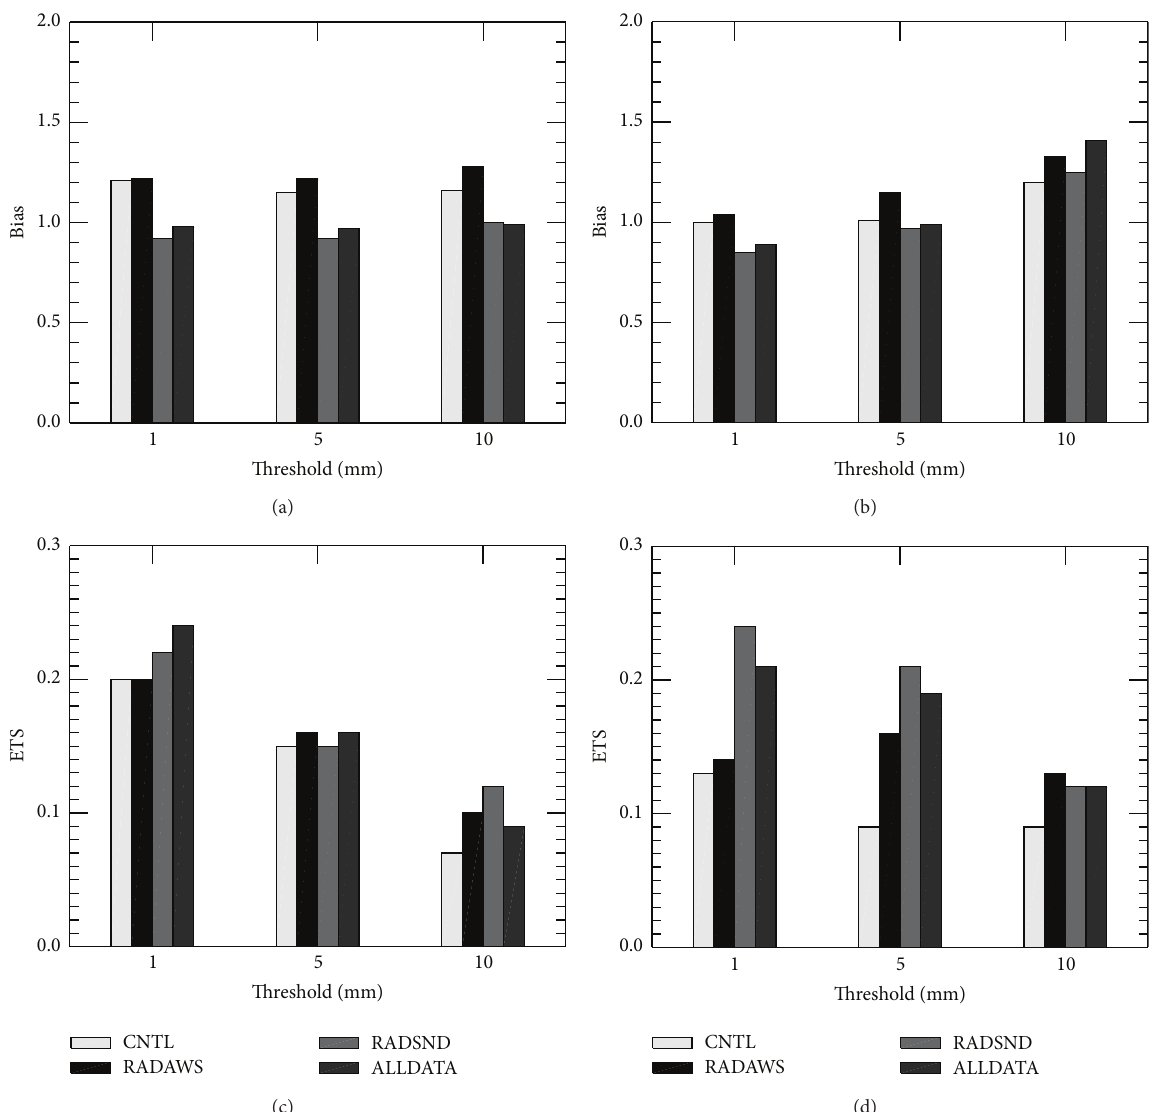
Figure 12: Bias score and ETS for 6h accumulated precipitation with the thresholds of 1, 5, and 10mm from the four experiments for case 20110629. Bias for (a) the first 6h and (b) the latter 6h precipitations and ETS for (c) the first 6h and (d) the latter 6 h